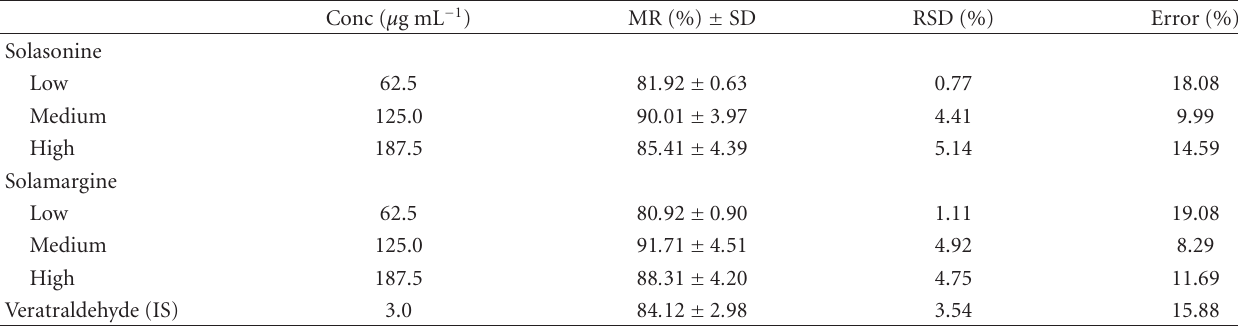
Table 4: Accuracy and recovery of solasonine, solamargine, and veratraldehyde.